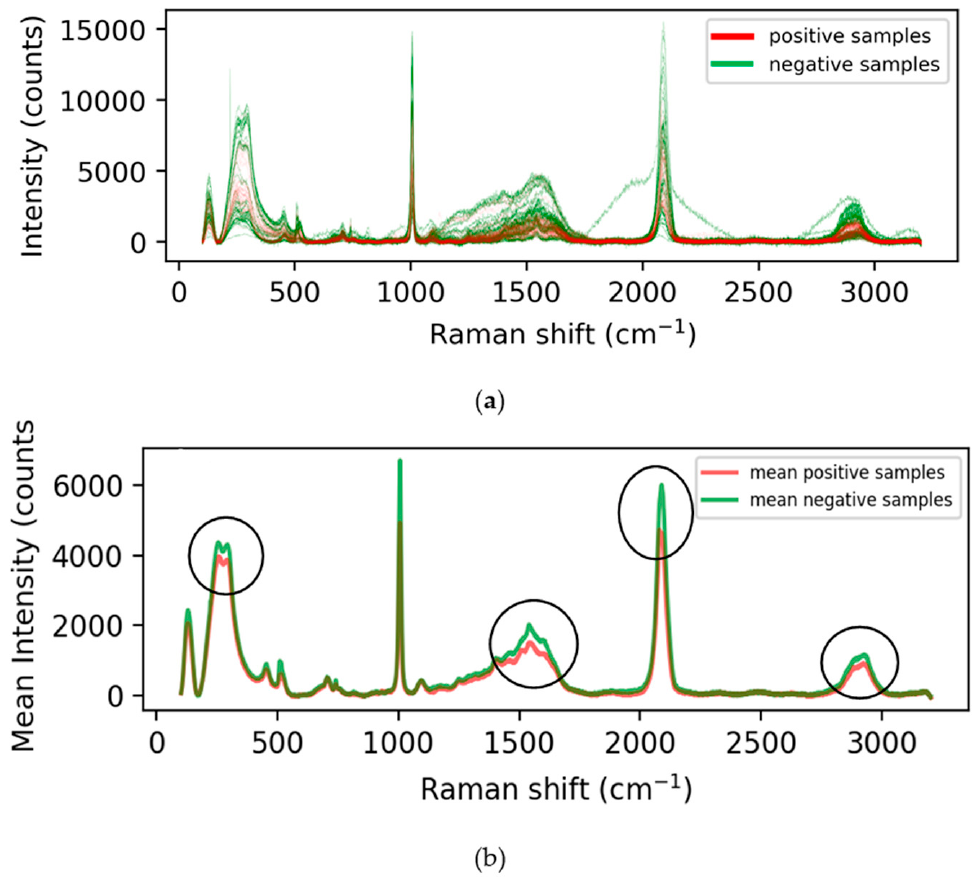
Figure 1. ( a ) Positive and negative SERS Spectral ( b ) Mean positive and negative SERS. The positive and negative SERS spectra were stacked together in an array, with the samples in the rows and intensity for a given Raman shift on the columns. This resulted in a dataset X ∈ R m × n , where m is the number of samples, and n is the number of Raman shifts. Before performing dimensionality reduction, the data was normalized between 0 and 1 to avoid low-magnitude features being weighted